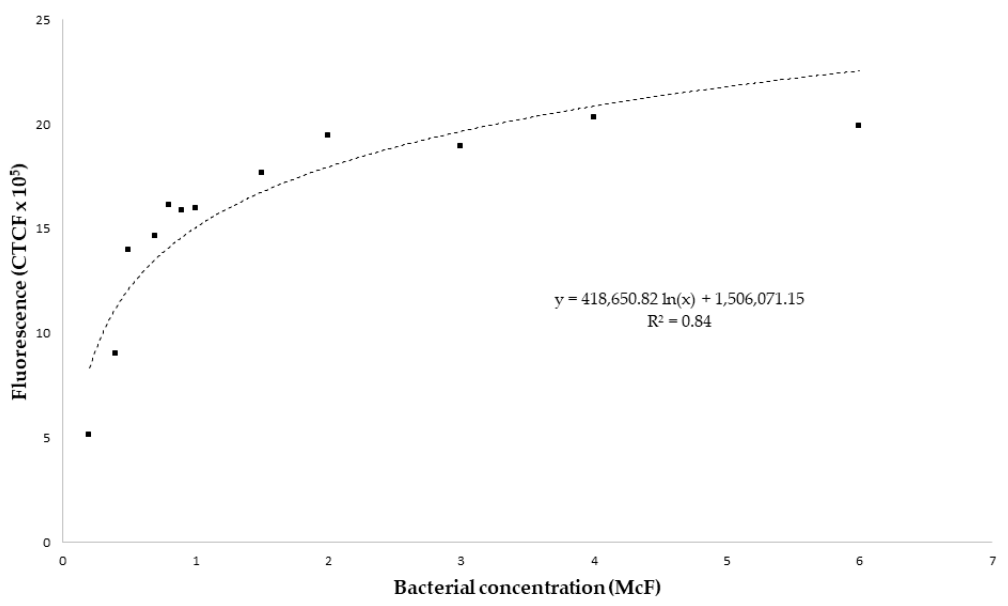
Figure 4. Fitting curve between the fluorescence measurements (CTCF) and the bacterial concentration (McF). Twelve vials with known concentrations of GFP- E. coli (0.2, 0.4, 0.5, 0.7, 0.8, 0.9, 1, 1.5, 2, 3, 4 and 6 McF) were photographed three times under the same conditions as the rhizotrons. The values presented are the means of these three measurements for each vial.